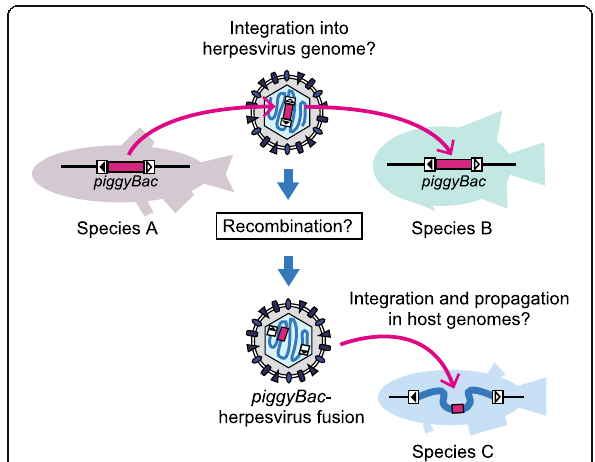
Fig. 5 Model: piggyBac -herpesvirus fusion resulting from virus-mediated transfer of transposons Fusion of piggyBac -like elements and Teratorn -like viruses could have originated from virus-mediated transfer of transposons across teleost fish species. Since herpesviruses invade the nucleus of host cells to establish latent infection, transfer of transposons between the host genome and virus DNA is theoretically possible. In some cases, rearrangement might occur within the virus genome to form a genuine piggyBac -herpesvirus fusion, making it possible for the virus to integrate and propagate in the host